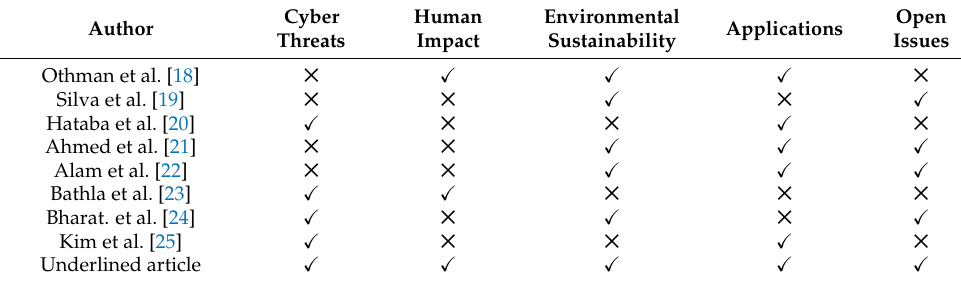
Table 1. Comparative analysis of various dimensions of existing